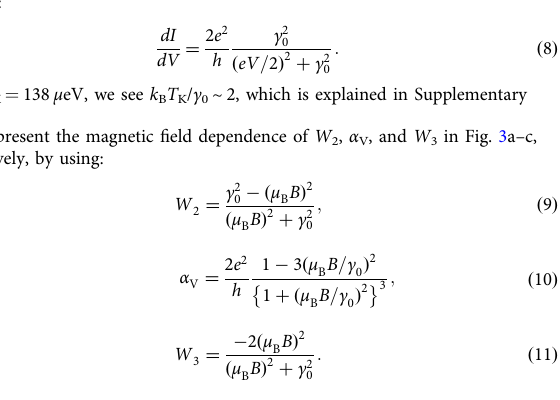
Fig. 4 Two- and three-body correlations as a function of the energy level. a Zero-bias conductance G 0 and phase shift δ σ as a function of ε / U . The marks are experimental results obtained at B = 0. The dashed curve for G 0 is given by the NRG calculations with U / Γ = 3.5. b Curvature α V as a function of ε / U . The dashed curve is the NRG results with U / Γ = 3.5. (Inset) dI / dV as a function of sign ð V Þ ´ ð eV = k B T K Þ 2 at ε / U = − 0.51 and − 0.65. Error bars correspond to the uncertainty of the linear fi t performed on slightly different ranges. c Three-body correlations W 3 as a function of ε / U . We compare the experimental results with the NRG results with U / Γ = 3.5 (dashed curve) 20-23 . The error bars are determined based on those of α V shown in Fig.